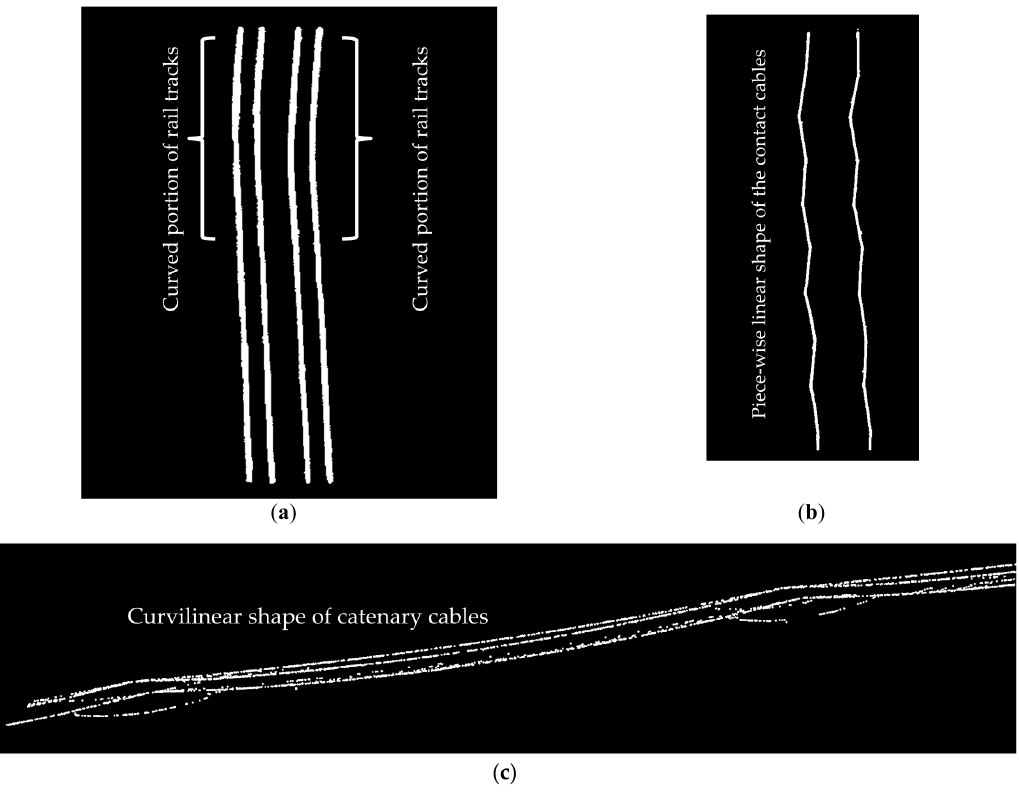
Figure 18. The physical shape of the objects of interest: ( a ) The curvature of rail tracks is indicated from plan view; ( b ) Piece-wise linear shape of the contact cables is shown from plan view; ( c ) The curvilinear shape of catenary cables is depicted from an oblique view.